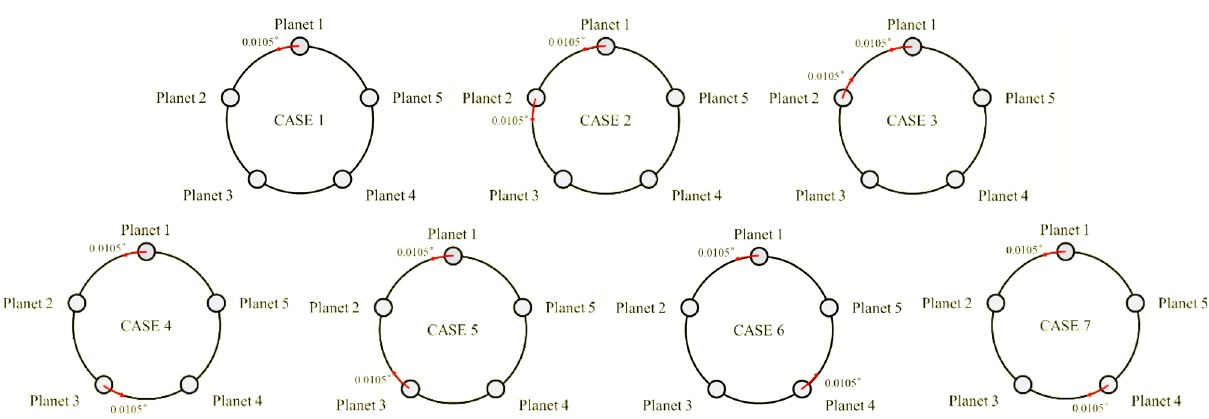
Figure 9. Various PPE analysis cases to ensure the robustness of load sharing effect of flexible